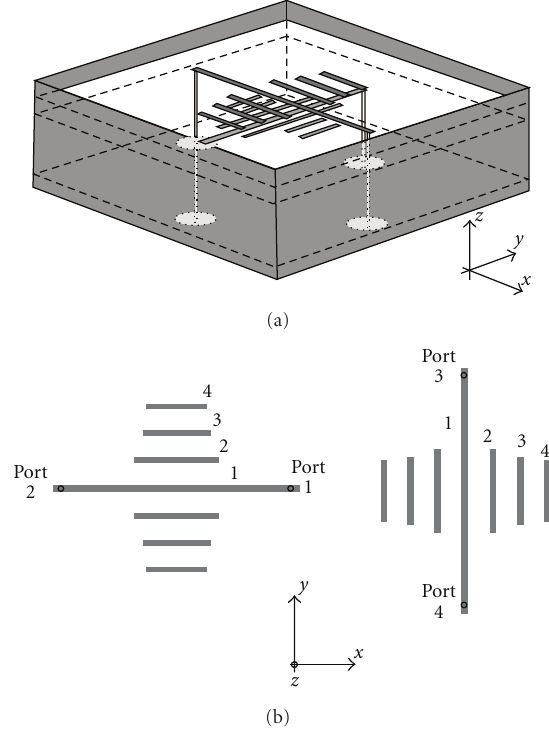
Figure 2: Geometry of the radiating element under analysis in Section 4, based on another rhombic element printed on the top layer, and a rhombic element printed on the second layer. (a) 3D view of the antenna. (b) Upper view of the structure. Same three- layer configuration as in Figure 1. Geometrical parameters of the patches of the upper element: w 1 = 1mm, l 1 = 29 . 6mm, w 2 = 0 . 8mm, l 2 = 10mm, w 3 = 0 . 6mm, l 3 = 8mm, w 4 = 0 . 6mm, and l = 7mm. The diameter of the probes feeding the upper element 4 is d = 0 . 24mm. Geometrical parameters of the patches of the lower element: w 1 = 0 . 6mm, l 1 = 26 . 8mm, w 2 = 0 . 6mm, l 2 = 15 . 6mm, w = 0 . 6mm, l = 6mm, w = 0 . 6mm, and l = 6mm. ( w i and l i 3 3 4 4 are the width and the length of the i th patch, resp.) The diameter of the probes feeding the lower element is d = 0 . 4mm. The size of the box is 40